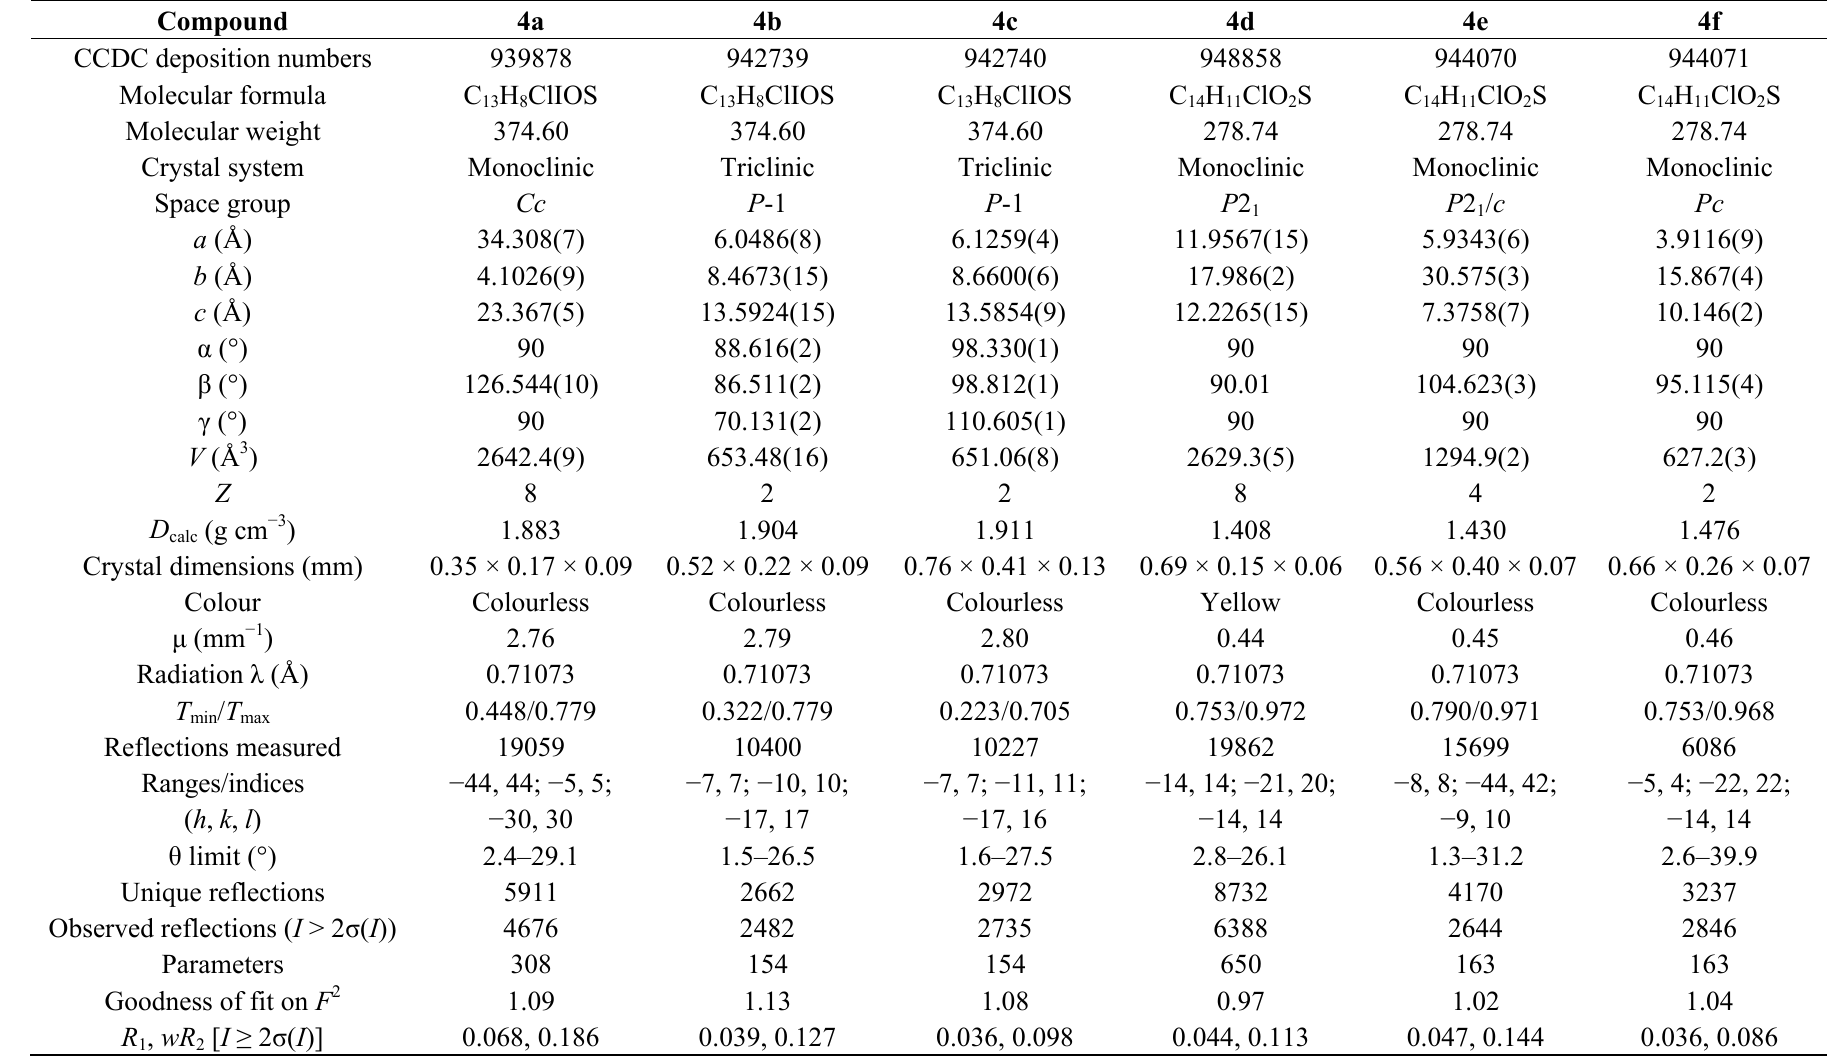
Table 1. Crystal data and parameters for structure refinement of compounds 4 ( a – f